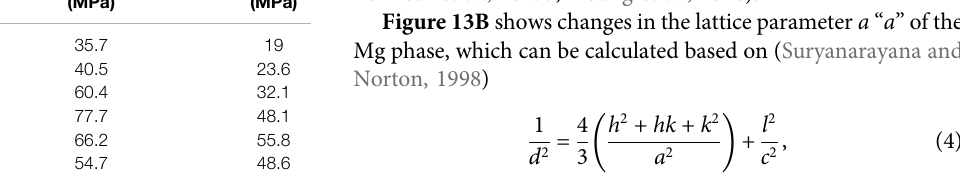
TABLE 2 | Estimated critical resolved shear stresses for prismatic slip and extension twinning calculated from Eq. 3 . Material